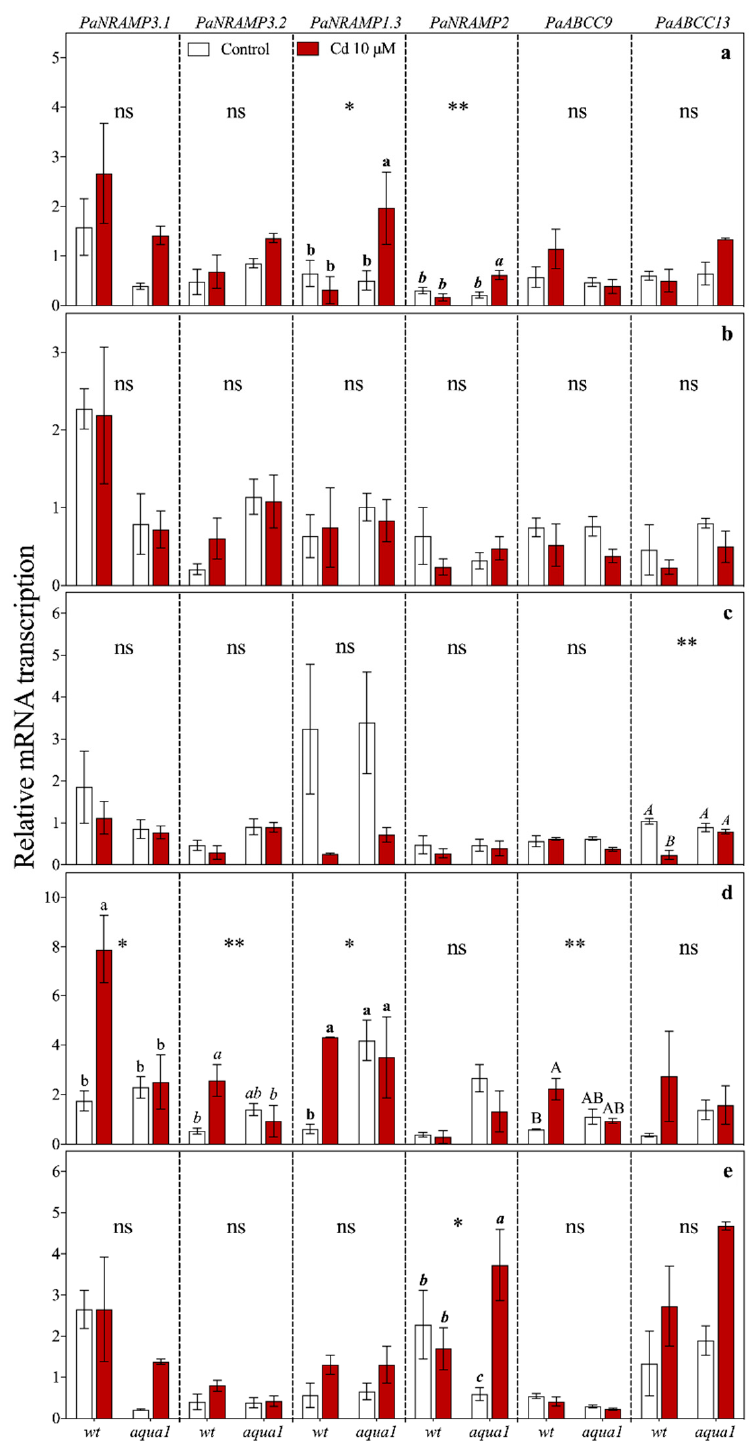
Figure 6. Gene relative transcript abundance in apical ( a ), medial ( b ), and basal ( c ) leaves, stem ( d ) and root ( e ) at 7 d of treatment. Values represent the mean of three biological replicates ± SE. Data were analyzed with two-way ANOVA; p -values correspond to the interaction between Cd and Line are reported in the figure (* = 0.01 < p < 0.05, ** = 0.001 < p < 0.01, ns = not significant). When the interaction was significant, different letters indicate significant differences among treatments at each sampling time and organ. Cd and Line p -values are reported in Supplementary Materials Table S3.